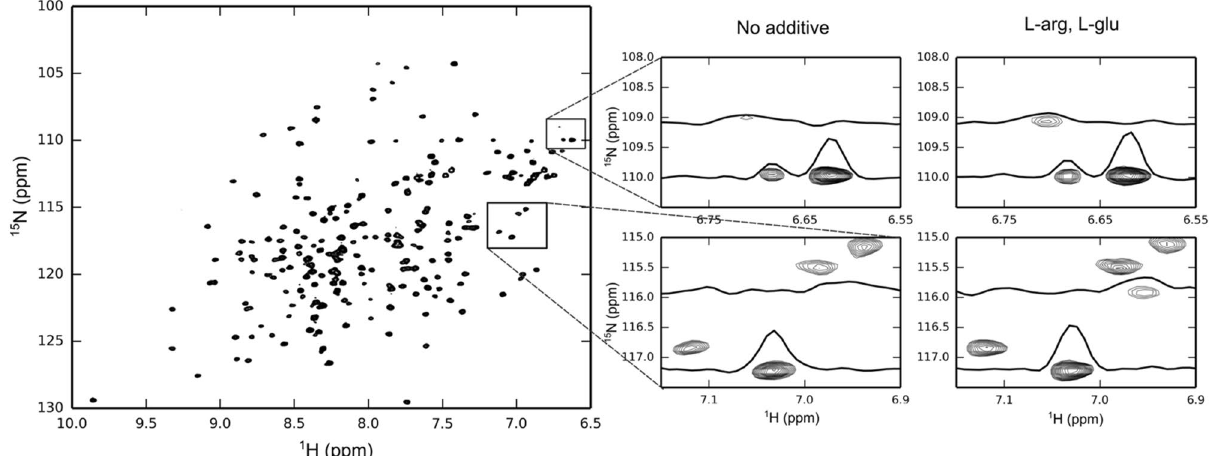
Figure 6. Optimized buffer conditions improve the quality OSM NMR spectrum. 1 H, 15 N HSQC spectrum of 100 μM 15 N-labeled OSM in 50 mM sodium phosphate, 100 mM sodium chloride, pH 6.6. Zoomed regions of interest from the 1 H, 15 N HSQC spectrum and projection along the 15 N axis of 100 μM 15 N-labeled OSM with no additive (left) and with 50 mM L-arginine, 50 mM L-glutamate (right). Spectra were collected with identical parameters, processed the same and plotted at the same contour levels.